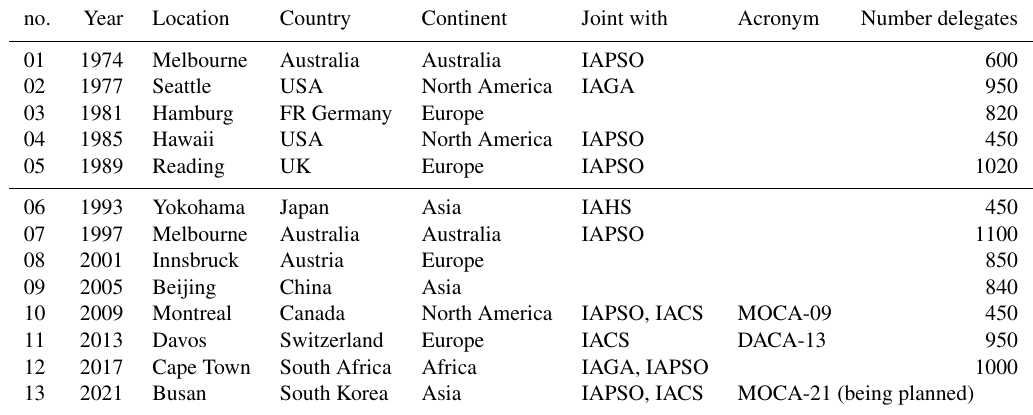
Table 4. General information about special IAMAP (no. 01–05) and IAMAS (no. 06–13) scientific assemblies convened between the general assemblies of IUGG, from 1974 onwards. For earlier assemblies, see the table of locations of general assemblies provided in the article on the history of IUGG (Ismail-Zadeh and Joselyn, 2019).